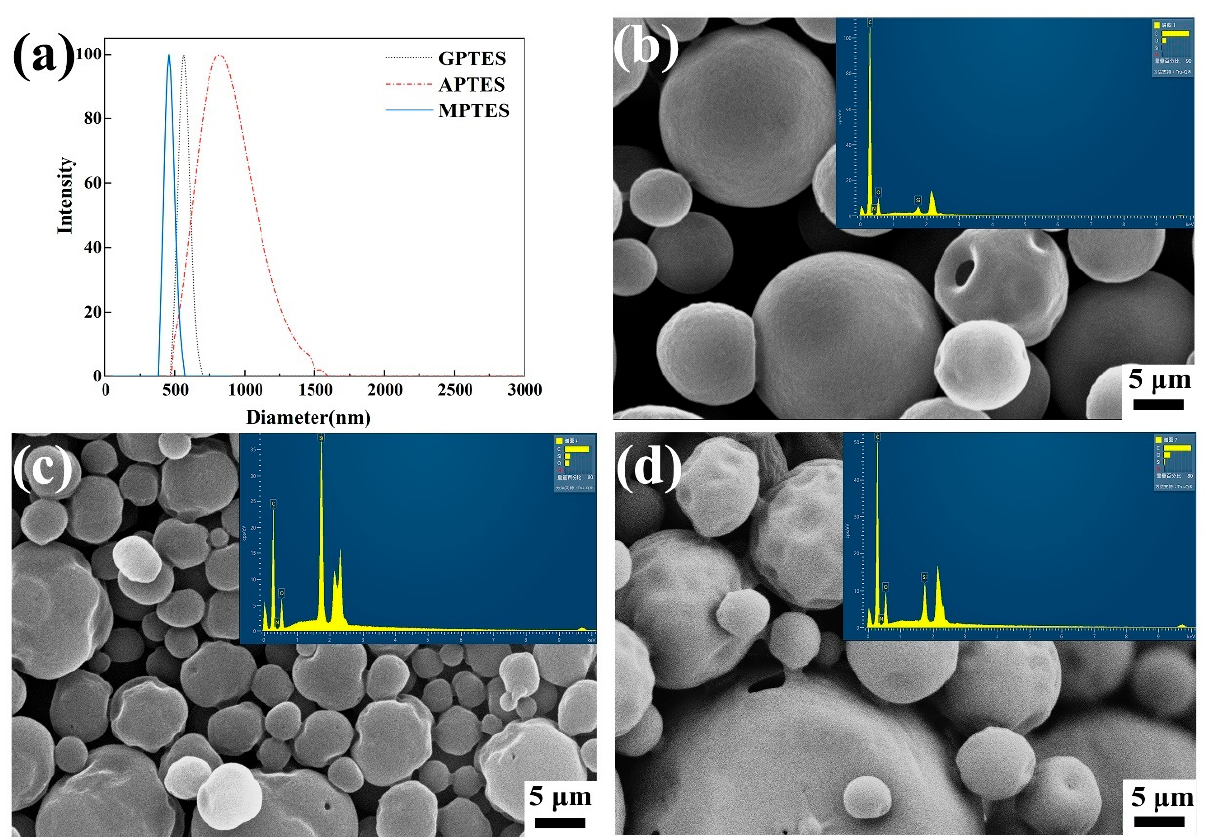
Figure 4. ( a ) Particle-size distribution of different modified essence microcapsules; ( b ) SEM image of GPTES-modified EC/SiO 2 fragrance microcapsules; ( c ) SEM image of APTES-modified EC/SiO 2 fragrance microcapsules; ( d ) SEM image of MPTES-modified EC/SiO 2 fragrance microcapsules.